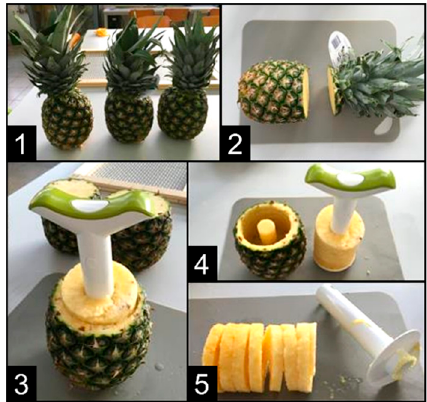
Figure 4. Preparation of samples: ( 1 ) fresh pineapples, ( 2 ) cutting of leaf crown, ( 3 ) cutting by means of rotational motion, ( 4 ) removing of the flesh, and ( 5 ) final spiral of flesh without